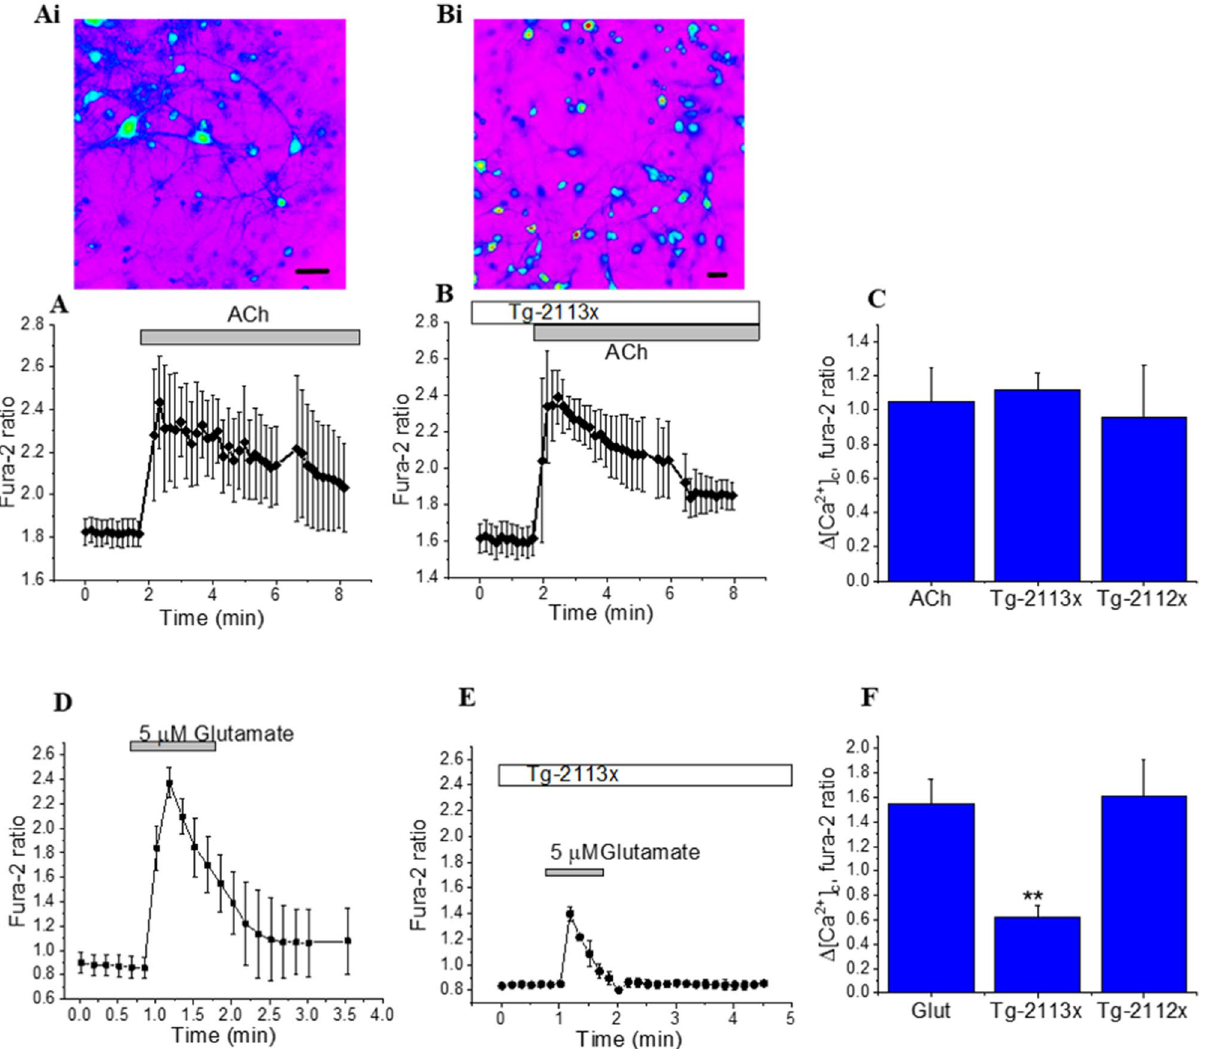
Figure 2. Effect of Tg-2113 on the amplitude of the acetylcholine- and glutamate-induced calcium signal. Effect of Ach (1 μM) on [Ca 2+ ] c of primary neurons in control ( A ) and in the presence of Tg-2113x ( B ) these data presented with typical images of fura-2 340/380 ratio with neurons and astrocytes (Ai. Bi). Bars on the images 20 μm. ( C ) Amplitudes of Ach-induced calcium elevation as changes in the Fura-2 ratio. Effect of 5 μM glutamate on [Ca 2+ ] c of primary neurons in control ( D ) and in the presence of Tg-2113x ( E ). ( F ) Summaries of the effects of Tg-2113x on glutamate-induced calcium signal. *p < 0.05; **<